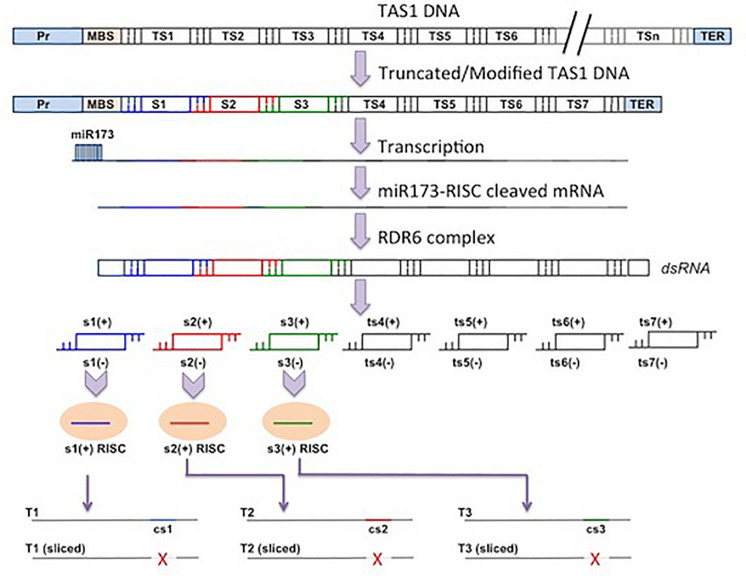
Schematics of artificial or synthetic tasiRNA (s) induced silencing (SIGS) using TAS1 DNA as vector backbone. ‘TS’ represents DNA encoding tasiRNA and ‘S’ represents DNA encoding synthetic tasiRNA, which replaces the ‘TS’ DNA. The sequence of ‘S’ is designed to slice (X) the T-mRNA. Following cleavage of mRNA, as transcribed by the engineered TAS1 DNA, by miR173-RISC, the 3′ fragment of the cleaved mRNA is converted to dsRNA by RDR6-SGS3 complex. DCL4 dicing releases the synthetic (s) tasiRNAs which eventually slice the T-mRNA. The other abbreviation used are Pr: promoter; MBS: miR173 binding site; TER: Transcription termination sequence; + and −: both strands of the tasiRNA; T: mRNA target of the synthetic tasiRNA (s); cs: complementary sequence. Synthetic tasiRNA (s) are shown in different.